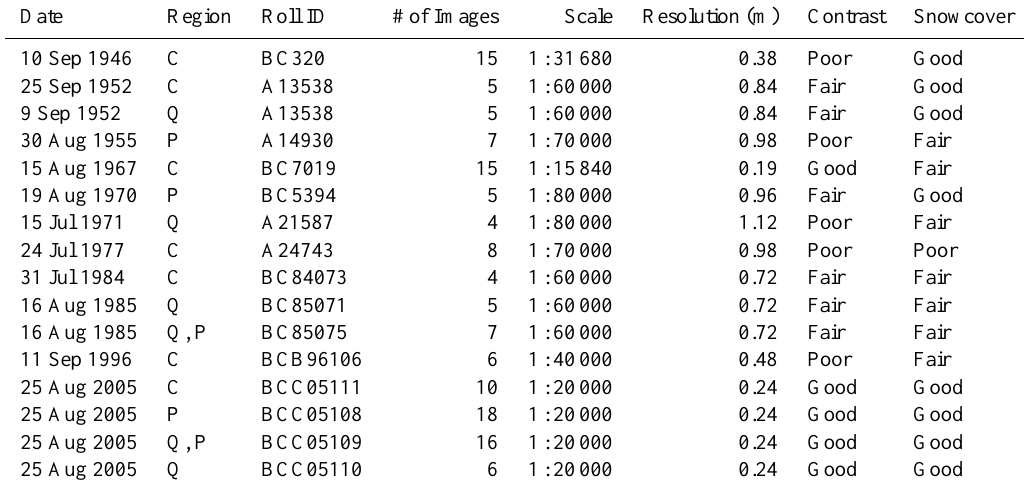
Regions: C: Castle Creek, Q: Quanstrom, P: Premier Range. Roll ID: BC: Provincial aerial photos, A: Federal aerial photos. Contrast: Subjective determination of image contrast on a scale from poor to excellent. Snowcover: Subjective determination of snowcover extent. Poor refers to